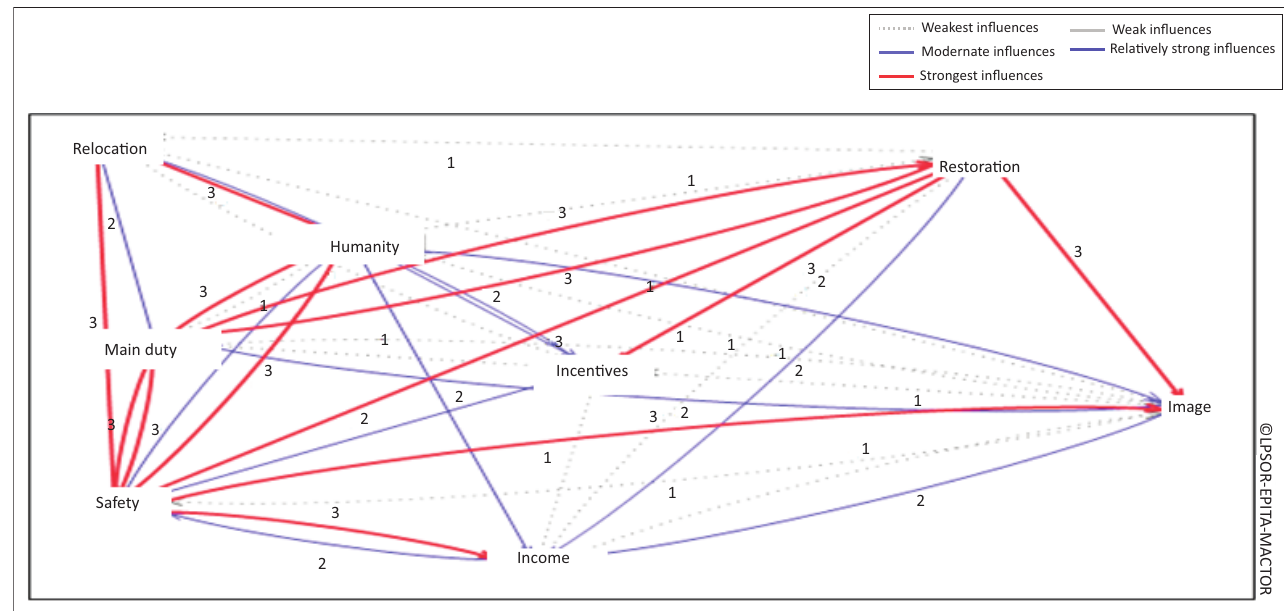
FIGURE 3: Relationship between stakeholders’